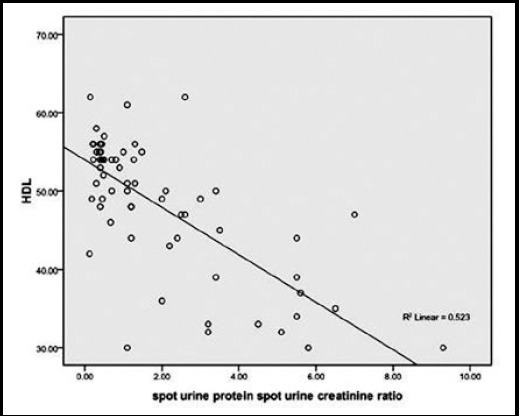
Correlation of HDL and Proteinuria.